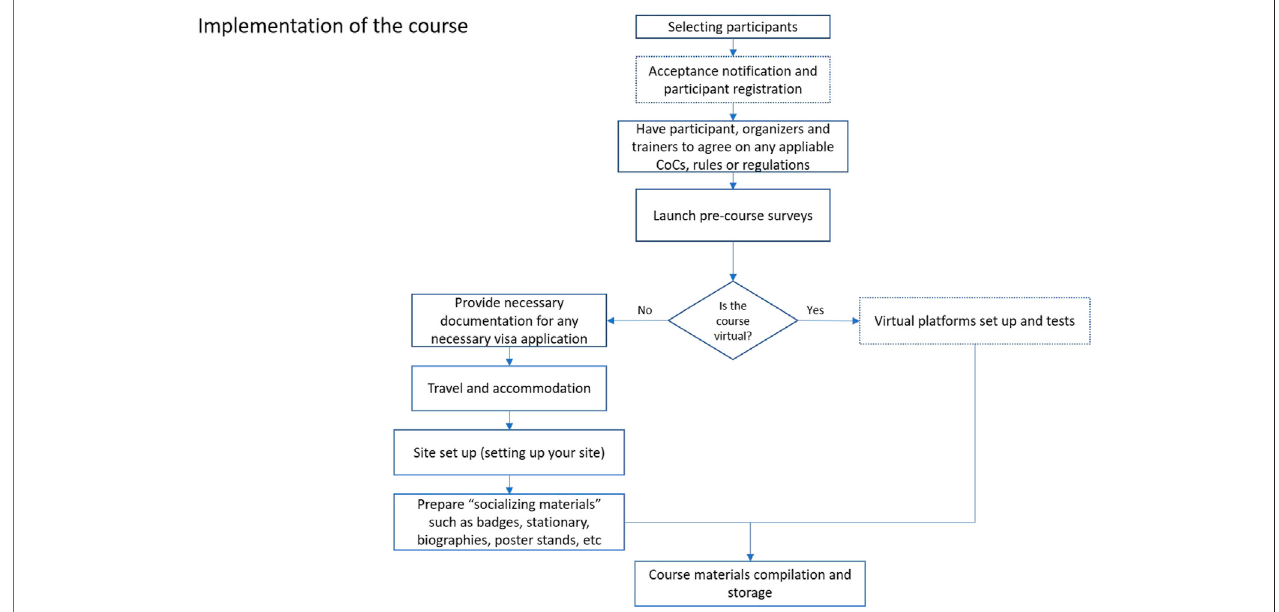
FIGURE 1 | Flowchart for implementing a bioinformatics training event. Diagram has been taken directly from the “ Best Practices for delivering Bioinformatics Training in LMICs ” living document and represents the set of steps advised by the contributors for implementation of a training event.